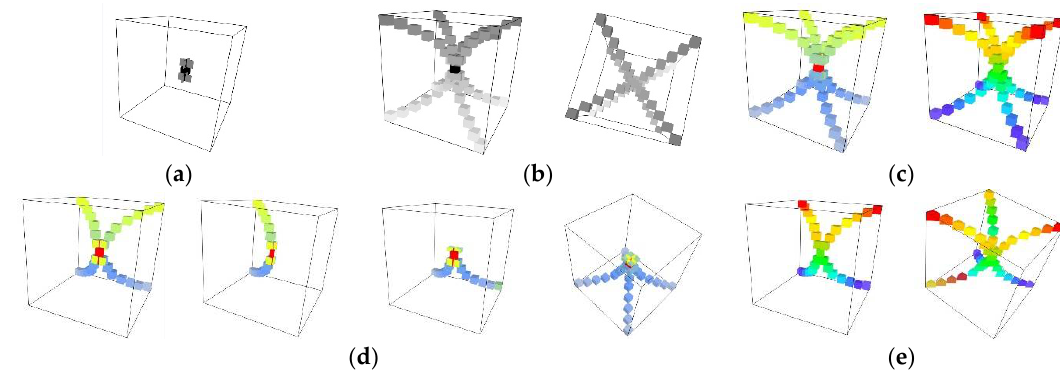
Figure 4. Visualizing the TotalTimeDensity volume and the AverageTimeDensity volume. ( a ) direct volume rendering of the trajectory stacking region using the grayscale color scheme; ( b ) two views of direct volume rendering of the TotalTimeDensity volume using the grayscale color scheme; ( c ) comparison of volume rendering of ( left ) TotalTimeDensity volume and ( right ) AverageTimeDensity volume using rainbow color scheme; ( d ) volume slicing of TotalTimeDensity volume in different directions and ( e ) volume slicing of AverageTimeDensity volume in different directions.